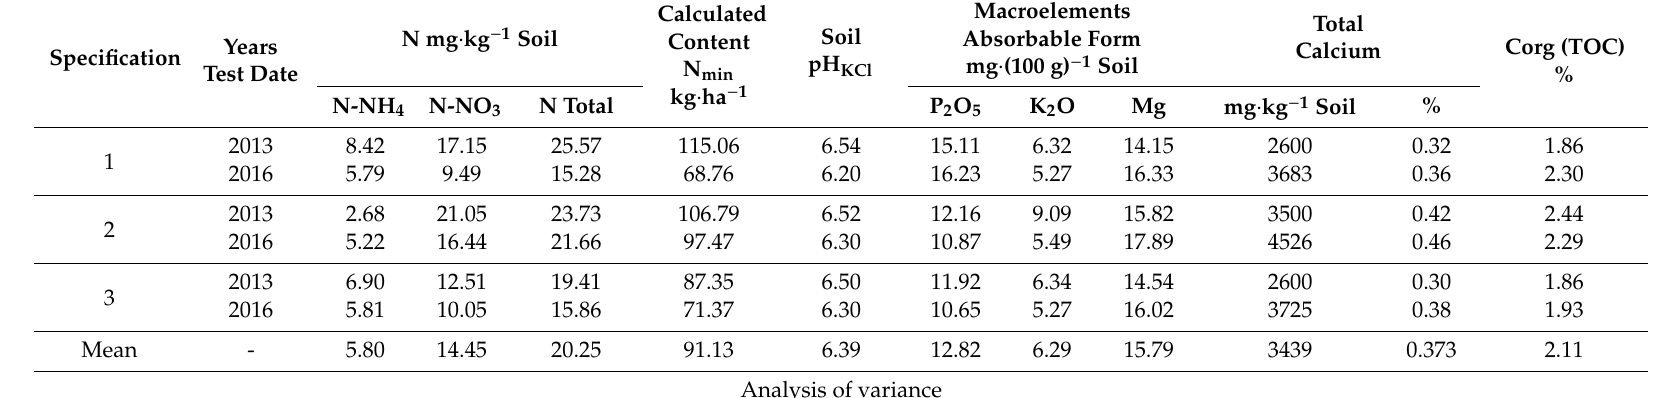
Table 5. Comparison of the content of particular components in the soil before and after the renovation of grassland (in the 30 cm layer of soil).